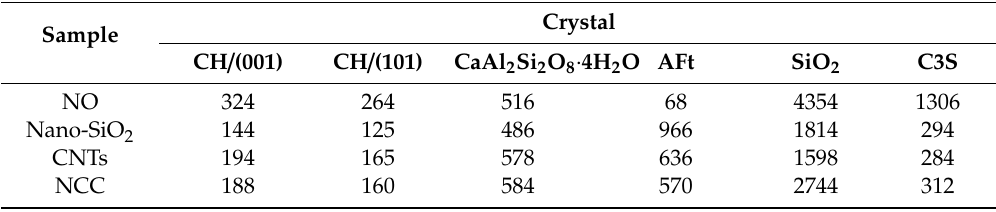
Table 3. Di ff raction peaks of cement hydration raw materials and products at 28 d of age.